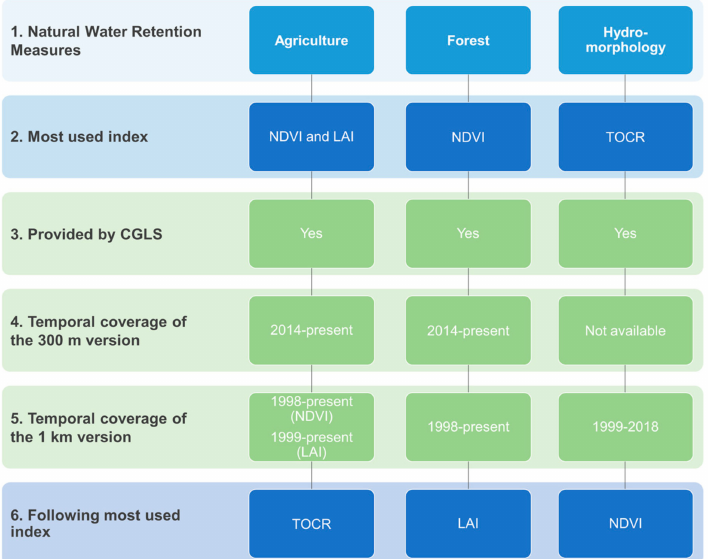
Figure A7. Decision flowchart indicating the most suitable indices available in the Copernicus Global Land Service for the monitoring of natural water retention measures.